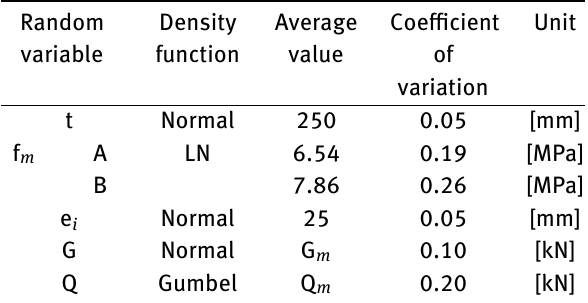
Table 3: Parameters of random variables occurring in the limit state function